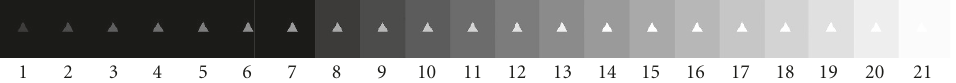
Figure 1: Example of a test image of triangles with changed brightness. The original image is the 7th image.